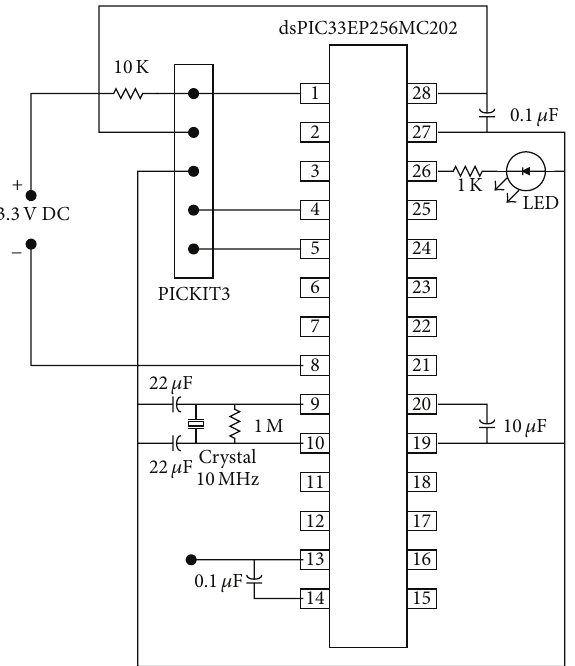
Figure 7: Minimum required circuitry to drive dsPIC33EP256MC202.